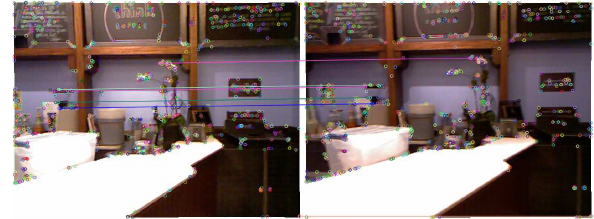
Figure 7. RMSE of the